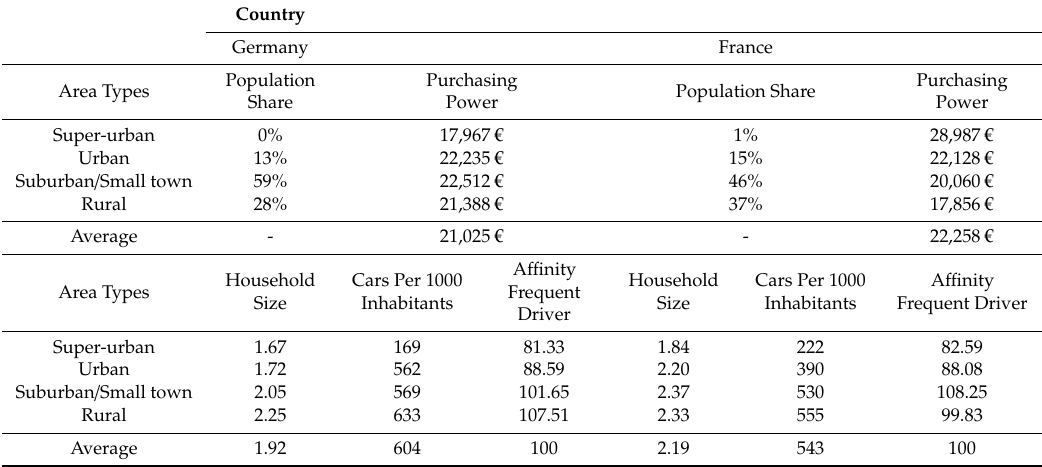
Table 4. Population distribution, purchasing power, average household size, car per 1000 inhabitants and a ffi nity frequent driver by area types and country. Country Germany France Population Purchasing Purchasing Population Share Share Power